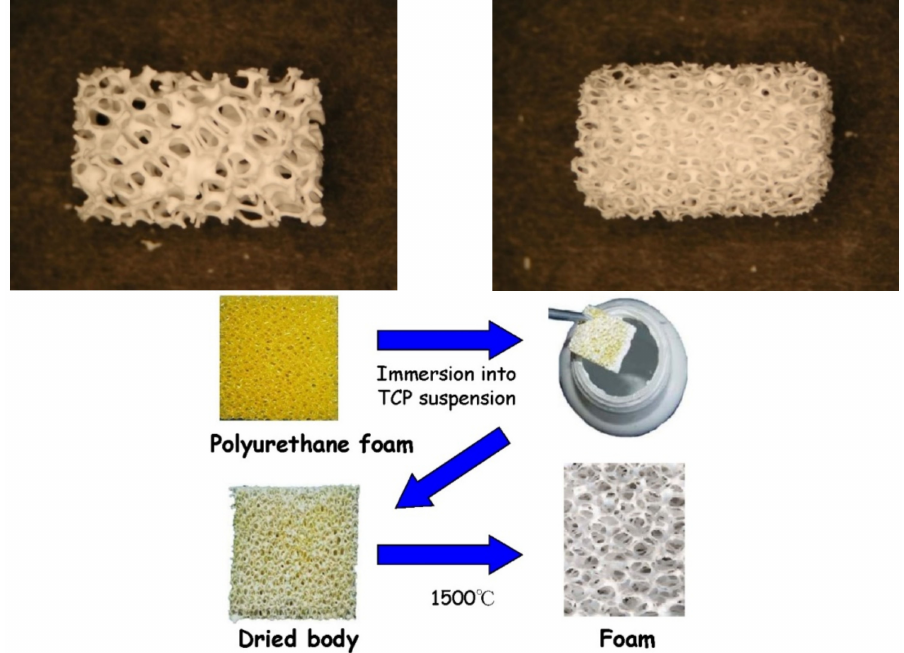
Figure 7. Photographs of commercially available porous CaPO 4 bioceramics with different porosity ( top ) and a method of their production ( bottom ). For photos, the horizontal field width is 20